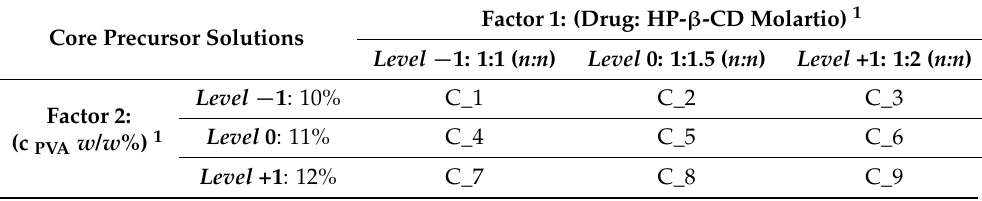
Table 1. Two factorial design table of the composition of precursor solution used for electrospinning experiments, which were then used as a core precursor solution in the coaxial fiber formation process. Core Precursor